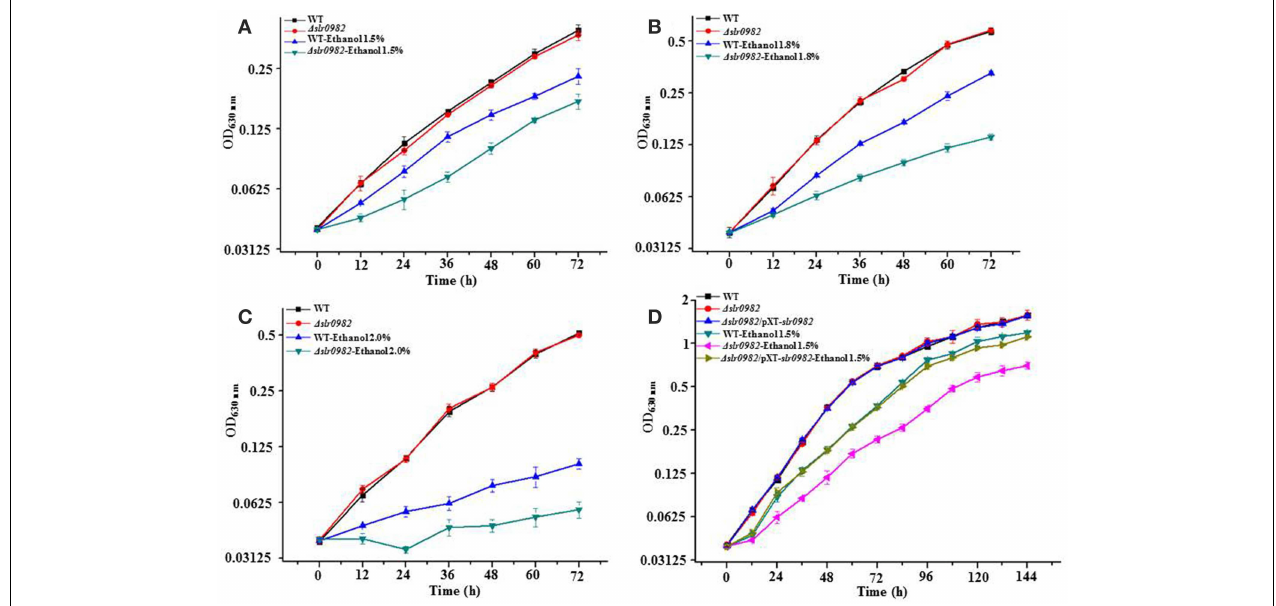
FIGURE 1 | Growth time curves of the wild type, the 1 slr0982 mutant and 1 slr0982/ pXT- slr0982 in BG11 media with or without ethanol. (A) and (D) , 1.5% ( v/v ); (B) 1.8% ( v/v ); (C) 2.0% ( v/v ).